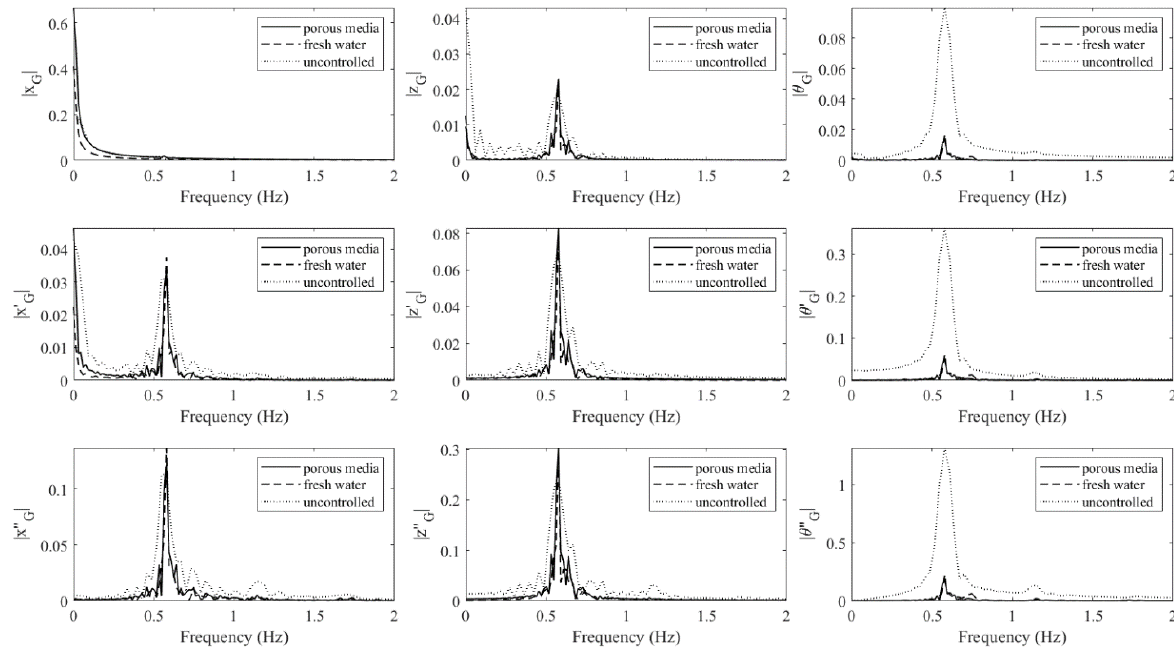
Figure 29. The response spectra of the controlled and uncontrolled floating bodies for the large-wave case.